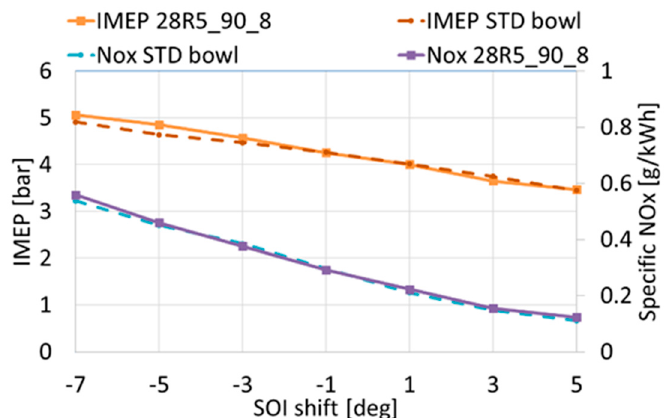
Figure 8. Comparison at PL between the standard bowl and 28R5_90_8 bowl in terms of the IMEP and specific NO x .